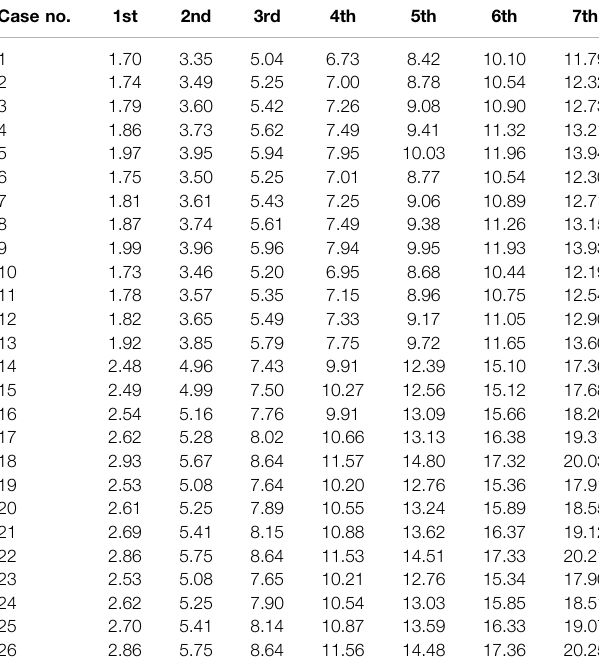
TABLE 11| Firsttoseventhmeasured modeshapesinascendingorderof m (top: ϕ m ( p ) ; bottom: ϕ m ( p ) 1 2 i i